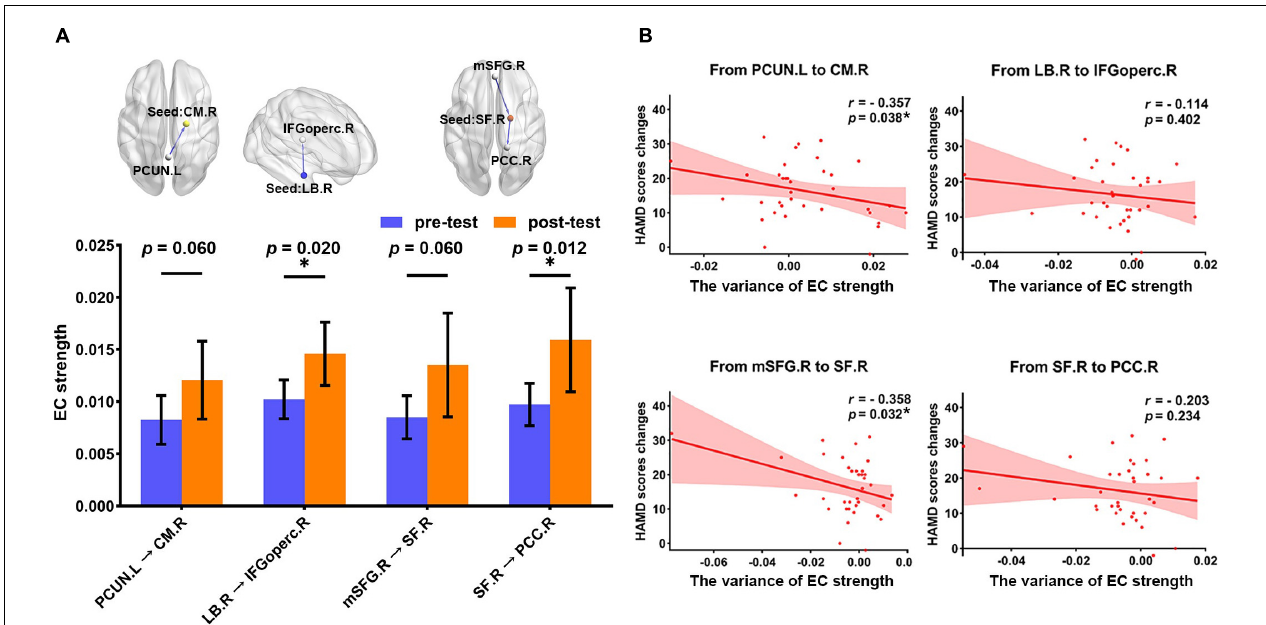
FIGURE 3 | The association of the changes in two different assessment methods between pre- and post-test of pharmacotherapy. (A) The histogram shows the variance in the EC strength between pre- and post-test of pharmacotherapy (FDR correction at p < 0.05), including the EC from the left PCUN to the right CM ( t = 1.942, p = 0.060), the EC from the right LB to the right IFGoperc ( t = 2.444, p = 0.020), the EC from the right mSFG to the right SF ( t = 1.941, p = 0.060), and the EC from the right SF to the right PCC ( t = 2.639, p = 0.012). * p < 0.05. (B) Scatter plots for the relationship between HAMD scores changes and the variance of EC strength. The significant correlation was found in the EC from the left PCUN to the right CM ( r = –0.357, p = 0.038) and the EC from the right mSFG to the right SF ( r = –0.358, p = 0.032). * p < 0.05. EC, effective connectivity; PCUN, precuneus; CM, centromedial amygdala; LB, basolateral amygdala; IFGoperc, opercular part of inferior frontal gyrus; mSFG, medial superior frontal gyrus; SF, superficial amygdala; PCC, posterior cingulate cortex; HAMD, 24-item Hamilton Rating Scale for Depression; L, left hemisphere; R, right hemisphere.